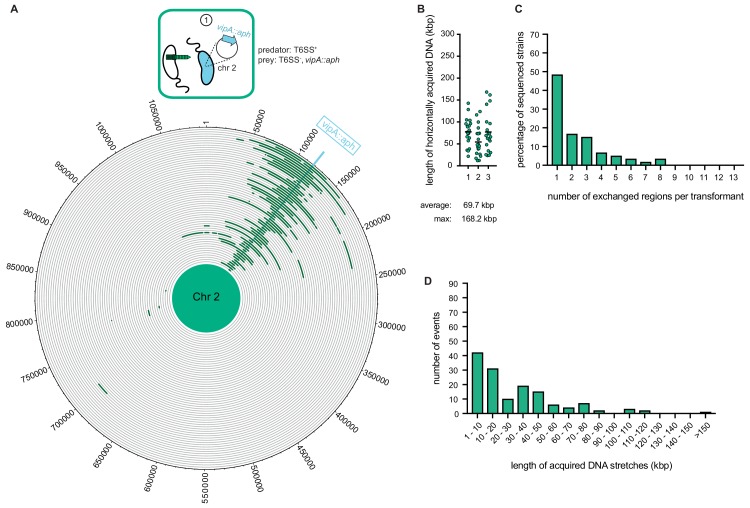
Whole-genome sequencing (WGS)-based quantification of horizontally acquired DNA.WGS analysis of transformants after prey killing and DNA transfer. Twenty kanamycin-resistant transformants were selected per independent biological experiment (n = 3). (A) The scheme represents the experimental setup of the co-culture experiment (condition ①). Sequencing reads for each transformant were mapped onto the prey genomes to visualize the transferred DNA regions (in dark green; see Figure 4—figure supplement 2 for both chromosomes). The position of the resistance cassette (aph) is indicated by the light blue line. (B) Total DNA acquisition frequently exceeds 100 kb. The total length of horizontally acquired DNA is indicated on the Y-axis for each transformant. Data are from three biologically independent experiments as indicated on the X-axis. Average and maximum lengths are indicated below the graph. (C) Multiple transferred DNA regions were identified in the transformants. Percentage of transformants (n = 60) that exchanged one or more DNA regions, as indicated on the X-axis. (D) Large DNA stretches are transferrable by transformation. The length of individual consecutive DNA stretches was determined as indicated on the X-axis.10.7554/eLife.48212.009Figure 3—source data 1.Raw data for Figure 3.